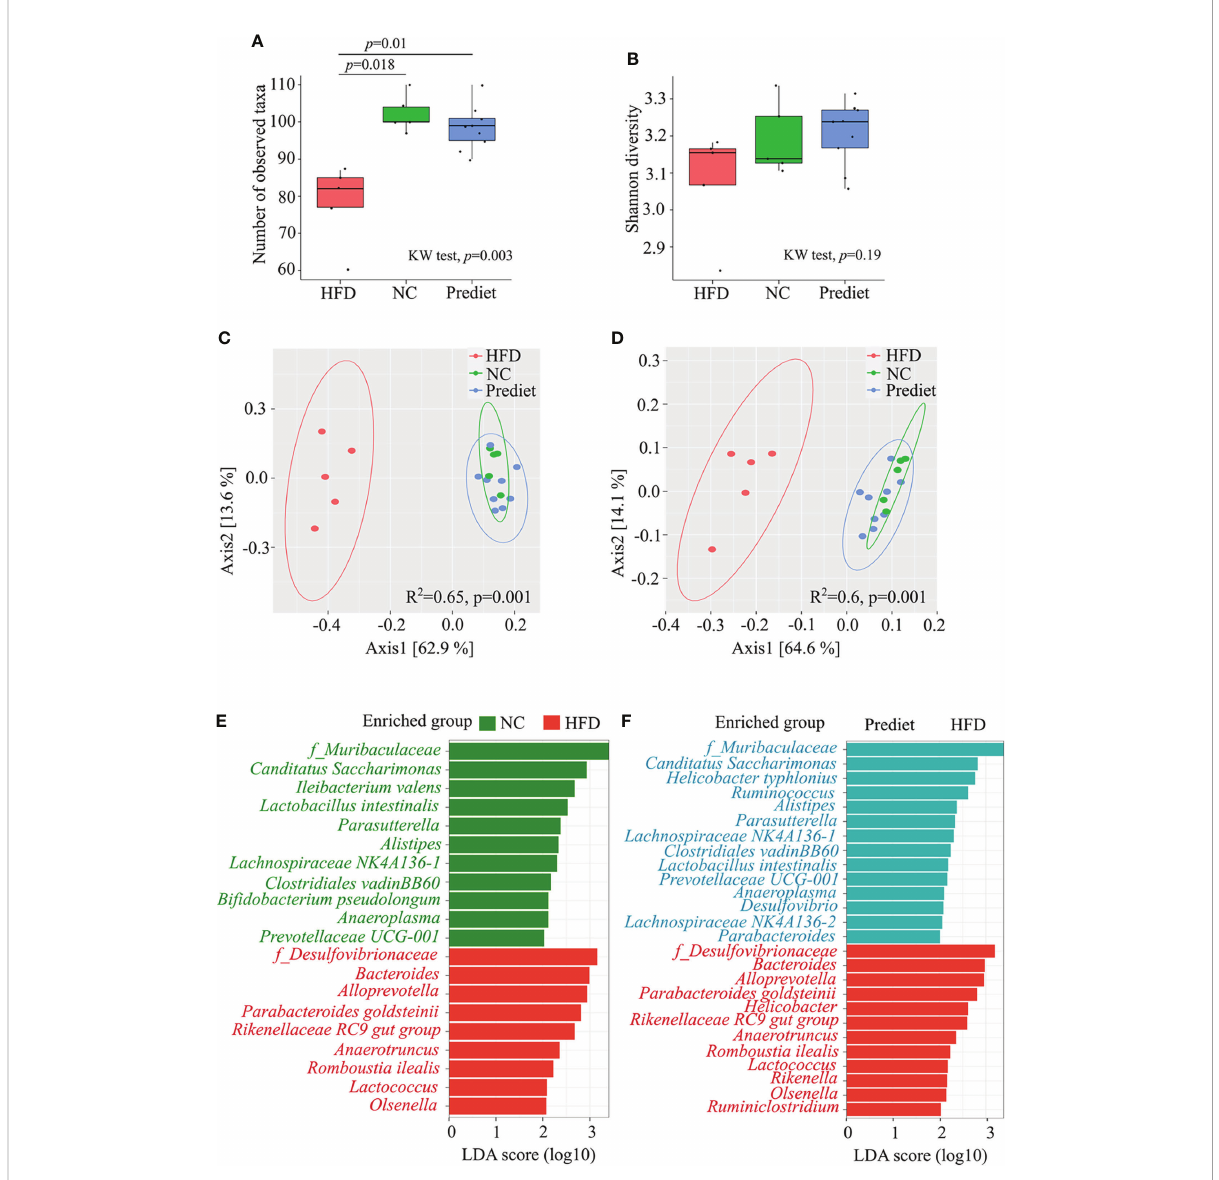
FIGURE 3 HFD induced obesity causes change in gut microbiota in HLA-DR3 transgenic mice. Amplicon based microbial diversity of mice on a prediet (n=9), a high fat diet (HFD, n=5) or normal chow (NC, n=5). Alpha diversity measures obtained using (A) Observed taxa, (B) Shannon diversity. PCOA plot representing beta diversity index measured using (C) Bray-curtis dissimilarity metrics, (D) Weighted unifrac measures among the groups. (E) Bar plot representing signi fi cantly altered taxa between HFD and NC, and (F) HFD and prediet conditions following lefse analysis in R among all taxonomic ranks with lda_cutoff of 2 and wilcoxon_cutoff of 0.01, and kw_cutoff of 0.01 respectively. Kruskal wallis (KW) test was performed for (A – C) followed by pairwise comparison using wilcox test and p -value with Benjamini Hochberg (BH) correction. adonis test was performed for (D, E)